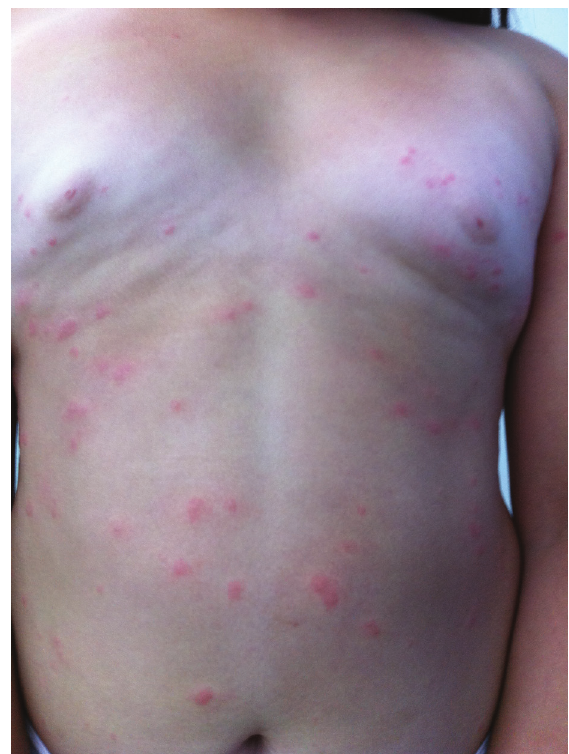
Figure 1 - Female child, surfer, with pruritic erythematous papules located on the chest and abdomen.